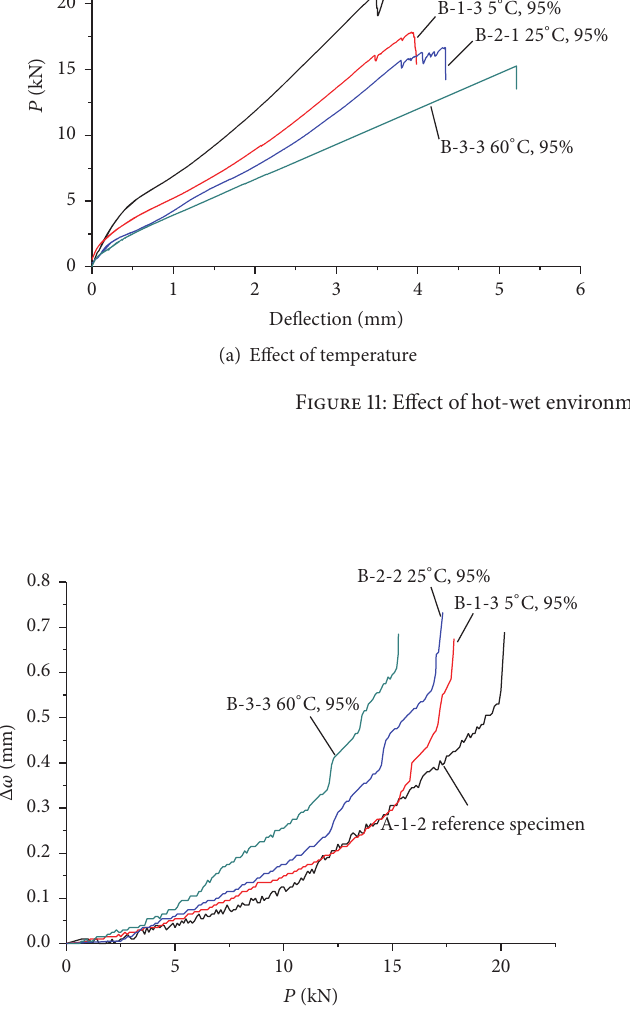
Figure 12: Hot-wet pretreatments effect on the relative slips ( Δ𝜔 ).